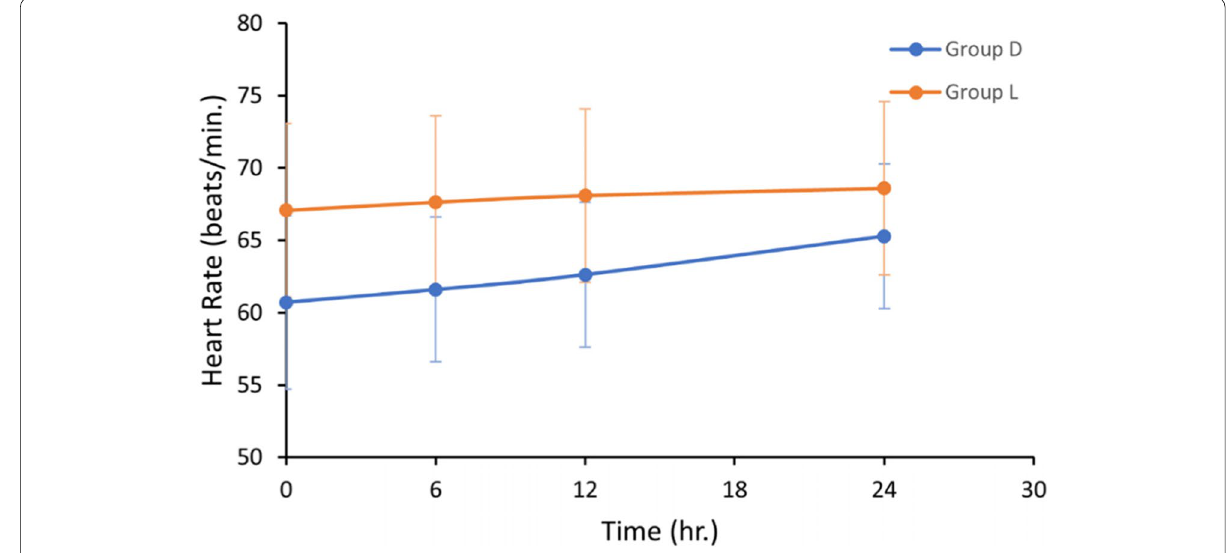
Fig. 3 Intraoperative mean arterial pressure for the two groups